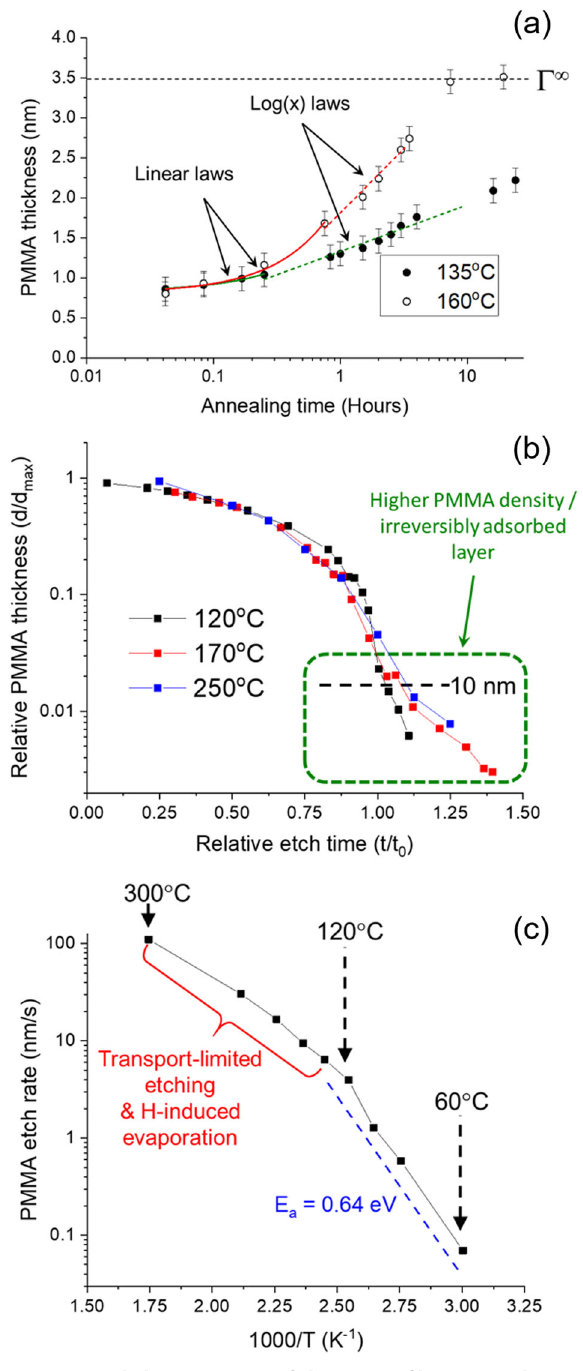
Fig. 1 Removal characteristics of the PMMA fi lm on Si substrates. a After overnight clean in acetone, adsorption kinetics for monolayer PMMA fi lms, indicating the presence of irreversibly adsorbed layer, not dissolved by the solvent. b Scaled thickness-time evolution of PMMA thick fi lms exposed to H 2 downstream plasma, at different substrate temperatures; d max ~ 570 nm and t 0 = t ( d = 0.03 × d max ). Below ~ 10 nm, the presence of the irreversibly adsorbed layer causes a change in etch mechanism. c Arrhenius plots of the average etch rate in H 2 downstream plasma, obtained by linear fi tting of the curve shown in b , for d > 50 nm. A threshold is visible around T ~ 120 ∘ C. The calculated activation energy is indicated on the graph. Error bars represent con fi dence intervals